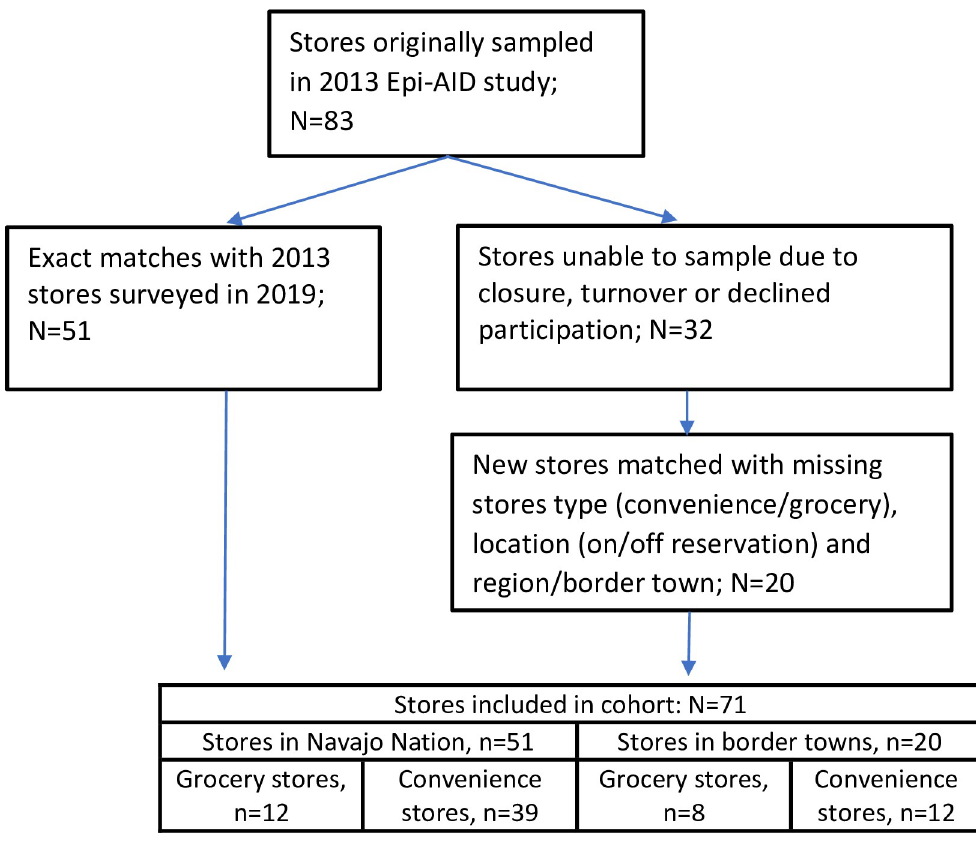
Fig 1. Flowchart of store